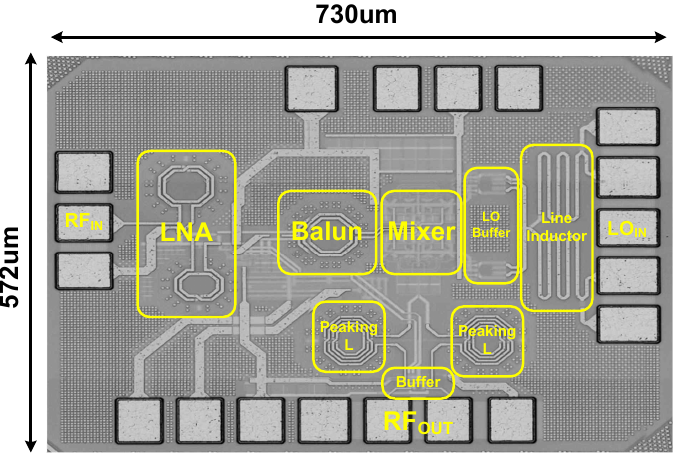
Figure 11. Chip photograph of the proposed receiver